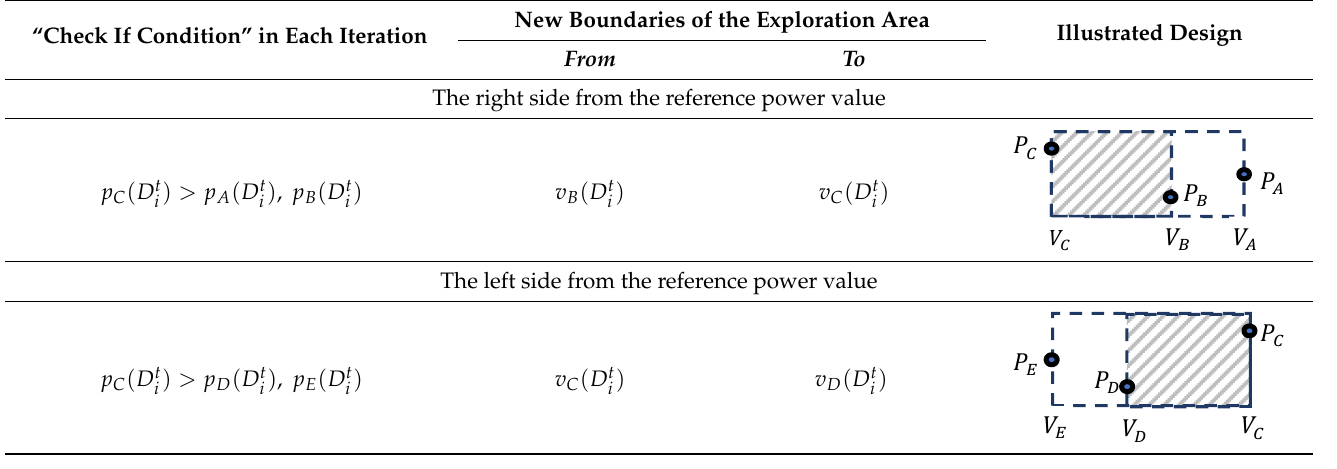
Table 1. The first condition that checked by the ICSA to update the exploration area.